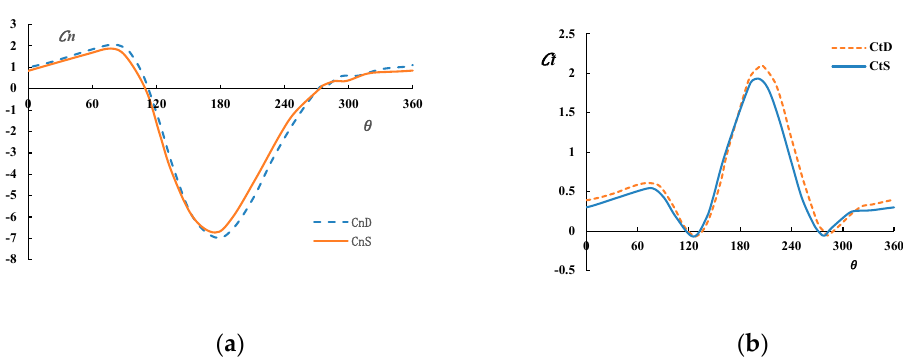
Figure 13. Tangential and normal force coefficient curves, ( a ) normal force coefficient curves of stand-alone turbine and twin-rotors system, ( b ) tangential force coefficient curves of stand-alone turbine and twin-rotors turbine.